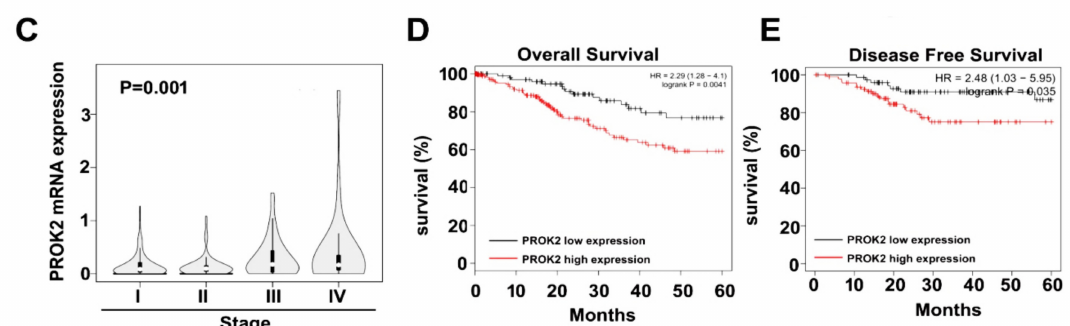
Figure 1. The expression of PROK2 in cervical cancer tissues and Kaplan–Meier analysis of cervical cancer patients’ survival rates in association with PROK2 expression. ( A , B ) Representative IHC staining of PROK2 in matched cervical cancer tissues and adjacent noncancerous cervical tissues with di ff erent staining intensity. ( C ) Validation of PROK2 expression based on the GEPIA databases for representative examples. ( D ) Overall survival rate (OS) and ( E ) Disease free survival rate (DFS) in patients with high or low PROK2 expression. The red line indicates high expression, and black line indicates low expression.